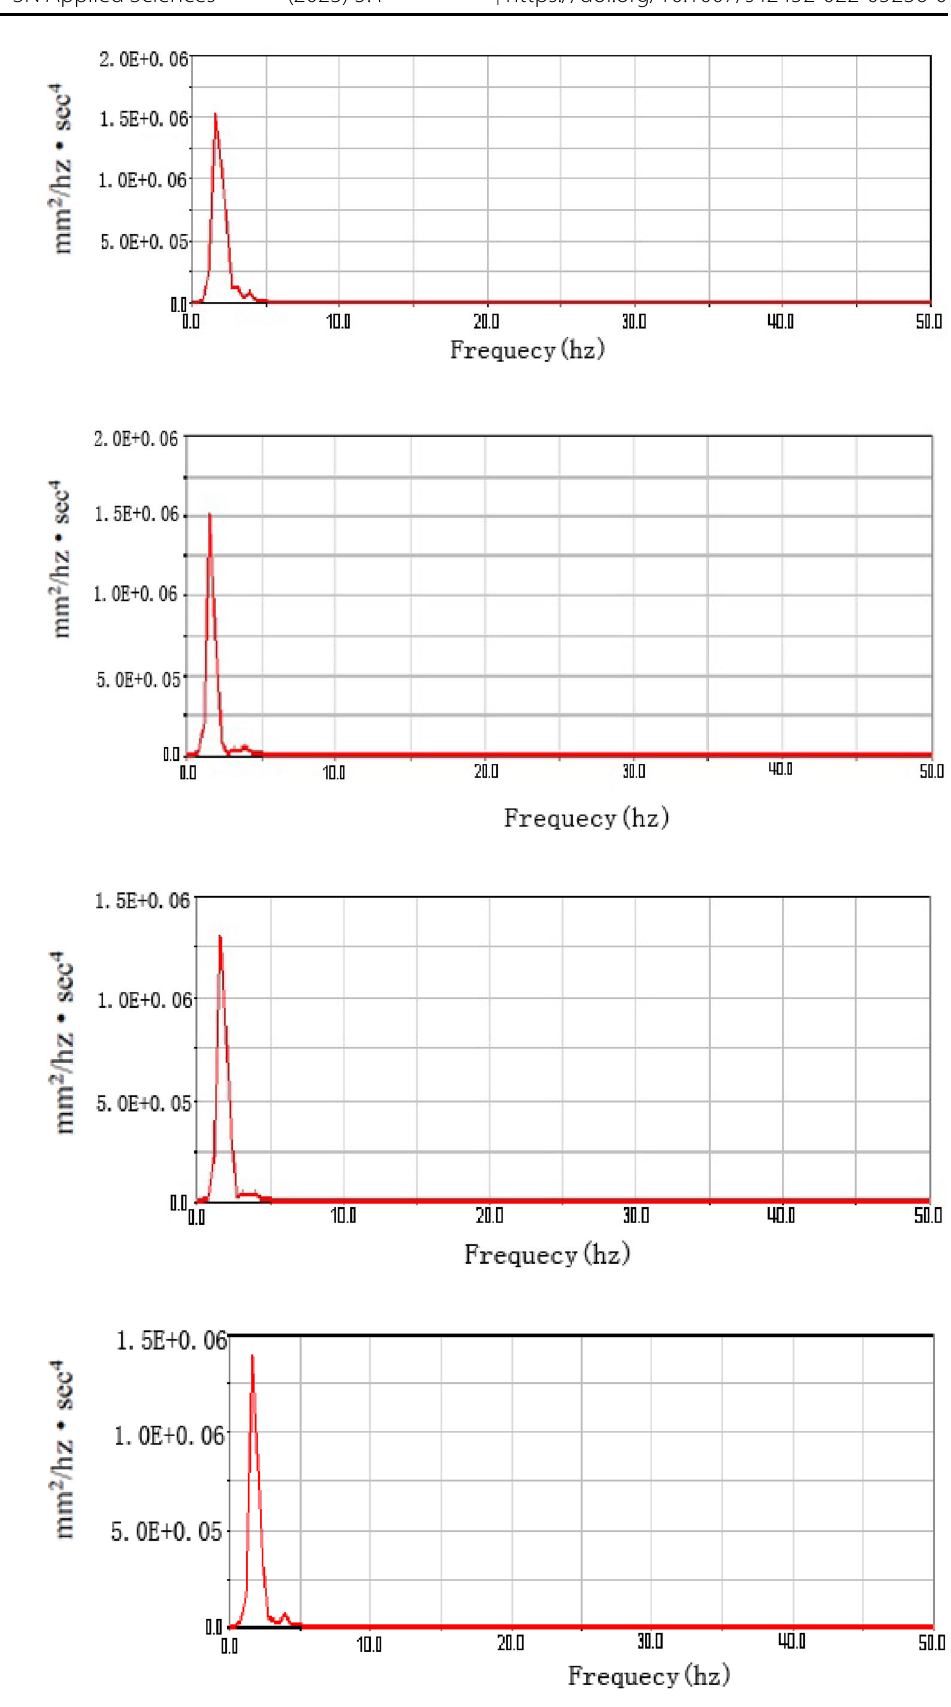
Fig. 9 Test 4 .Acceleration Response